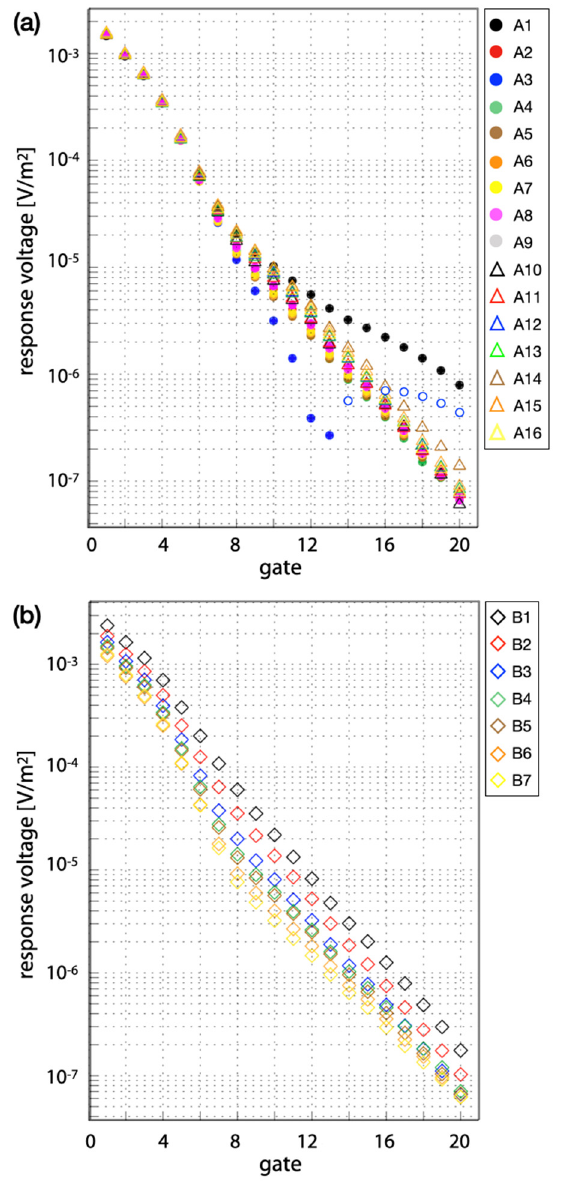
Figure 5. G-TEM data from 23 soundings in SE Malta. ( a ) All 16 soundings in profile A; ( b ) soundings from the 7 stations belonging to Profile B.